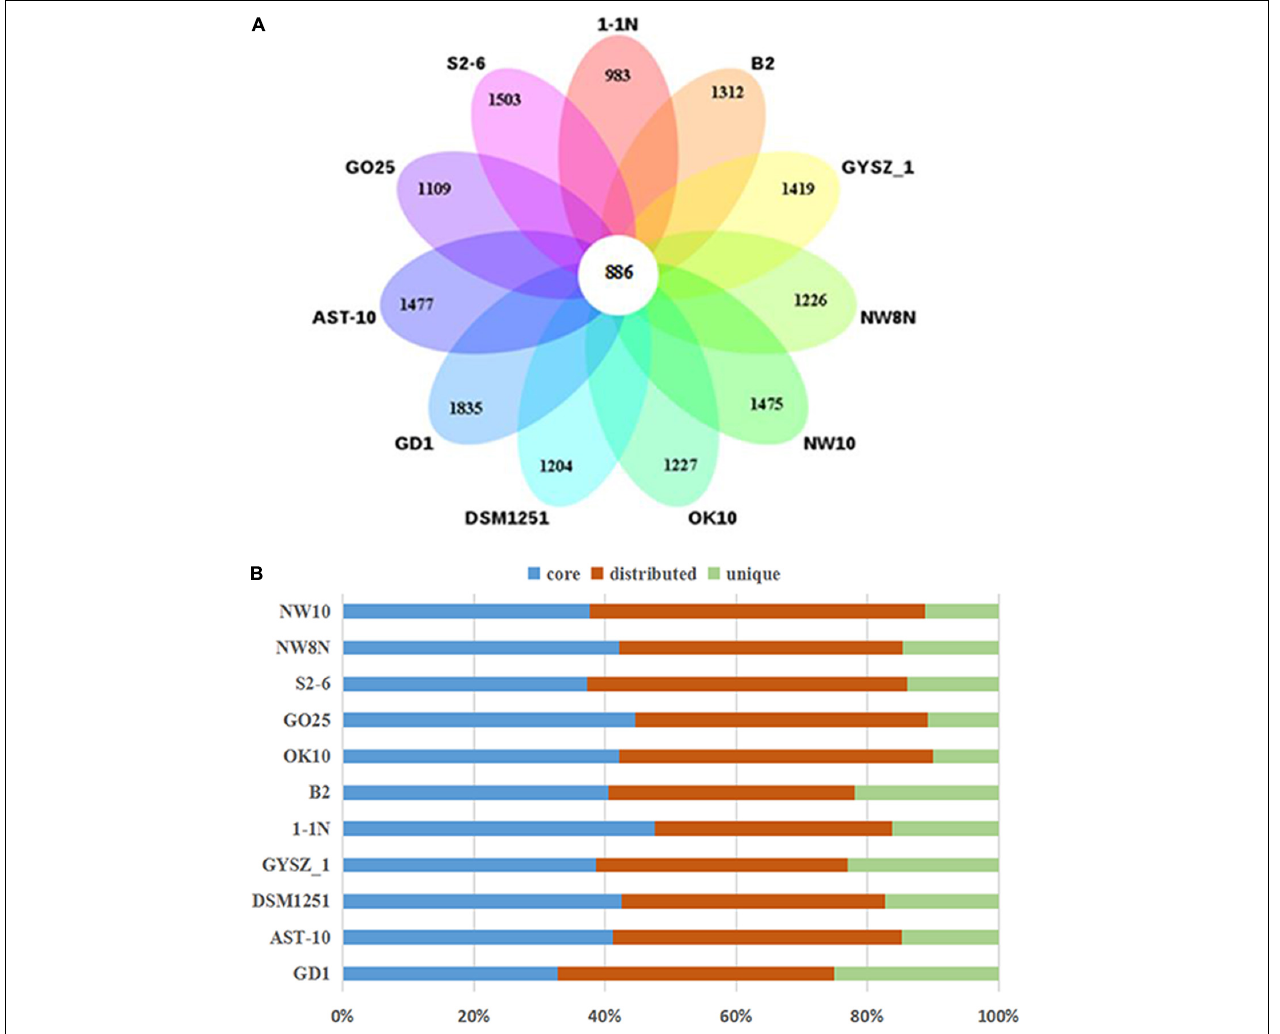
FIGURE 4 | Comparisons of Sulfurimonas orthologous protein groups in 11 Sulfurimonas genomes. (A) Venn diagram displaying the numbers of core gene families and flexible genes for each of the 11 Sulfurimonas strains. (B) Percentage of core, distributed, and unique genes in each of the 11